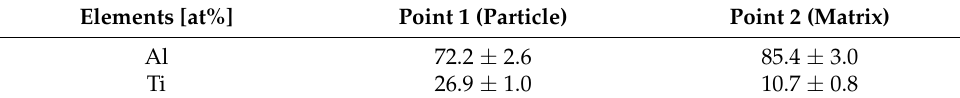
Table 4. EDS result on particle (point 1) and aluminum matrix (point 2) shown in Figure 14f.